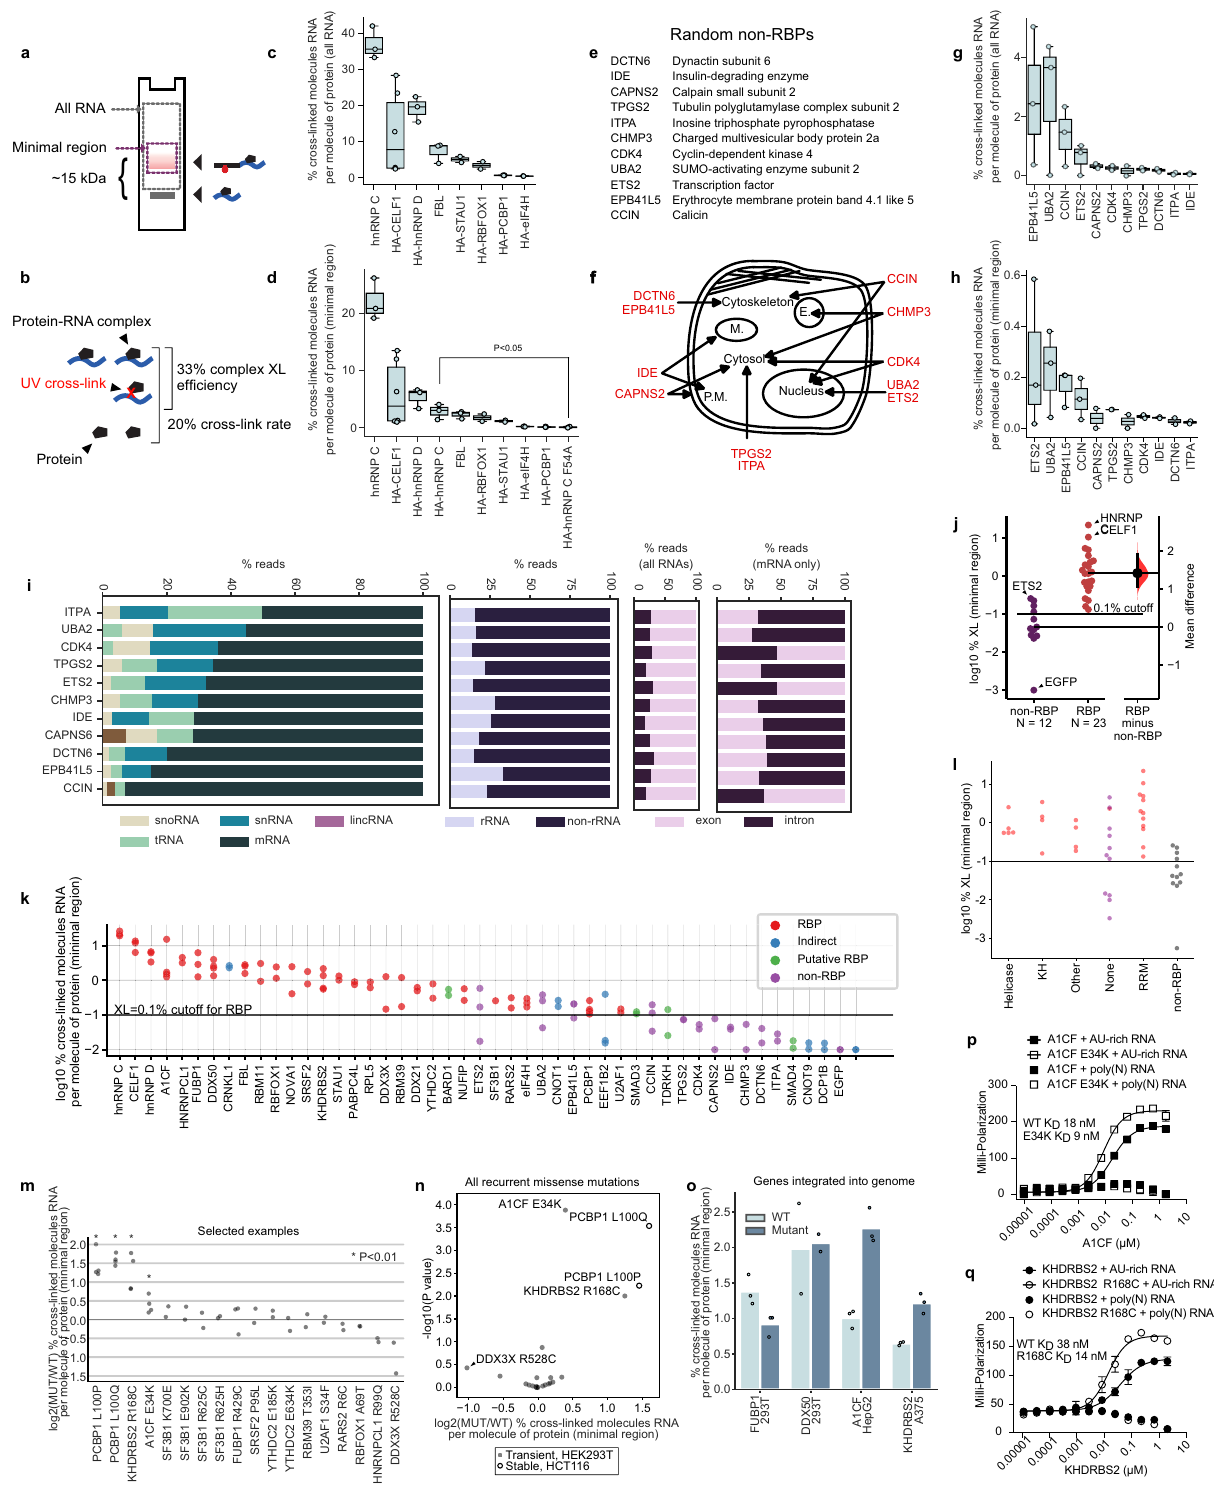
that recurrent cancer mutations in speci fi c RBPs may be asso- ciated with differences in RNA cross-link rates to their corre- sponding associated protein. the goals of this study was to enable target RNAs to be de fi ned for a protein of interest as those interactions with a frequency